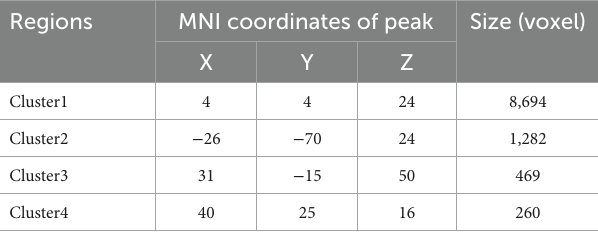
Only significant regions thresholded at p = 0.05, TFCE corrected.